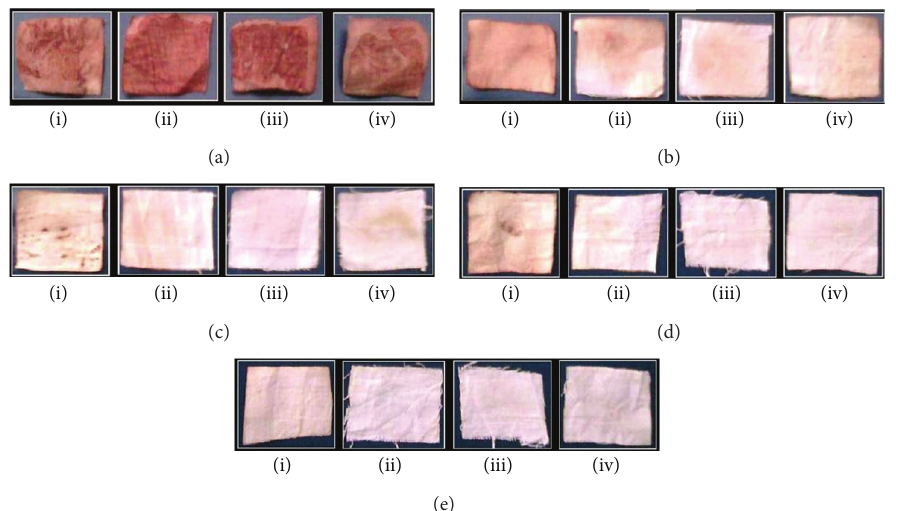
Figure 5: Evaluation of protease (CCP) for washing of goat’s blood stains from cloth (a) Control; (b) 5 min treated; (c) 10min treated; (d) 15min treated; (e) 25 min treated; (i) Buffer treated; (ii) Detergent treated; (iii) CCP treated and (iv) CCP + Detergent treated group.